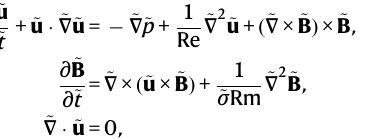
Fig. 10 | Residual hydrodynamic modes in simulation. Simulated normalized radial velocity pro fi le v r /( Ω 1 r 1 ) in the midplane. The red and blue regions represent outward and inward fl ows,